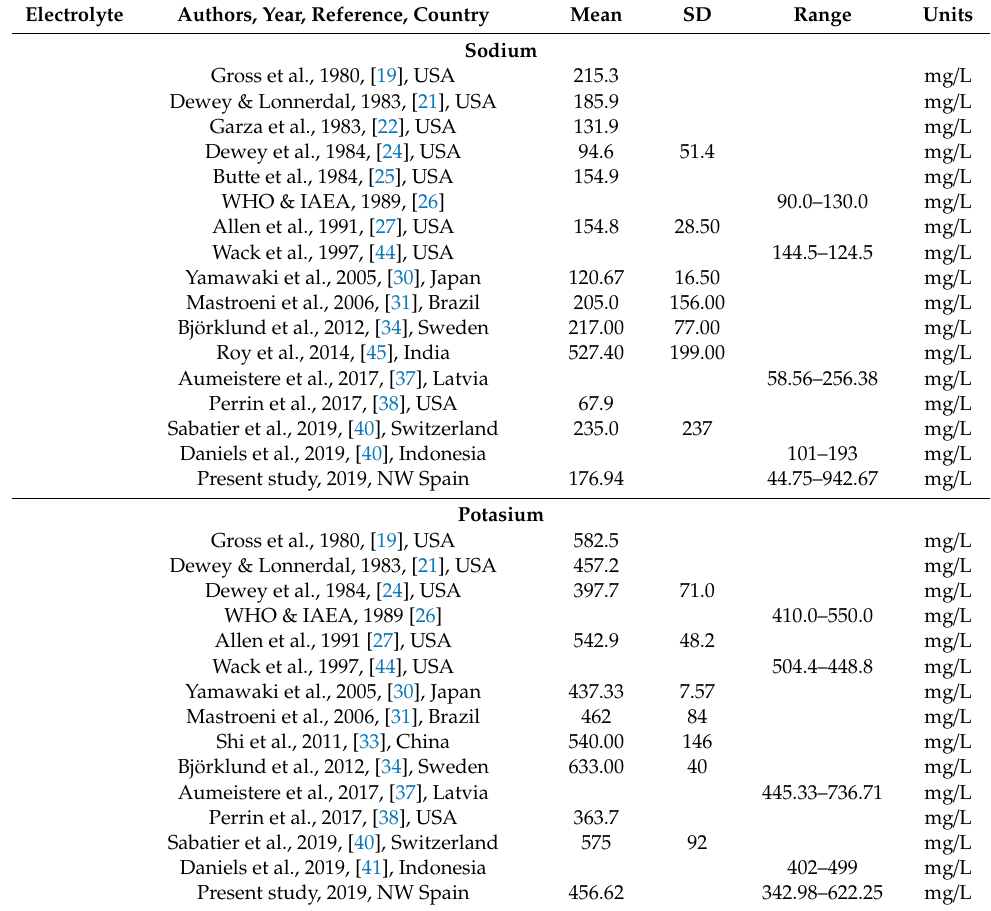
Table 4. Electrolyte concentration [18] reported in mature human milk in di ff erent